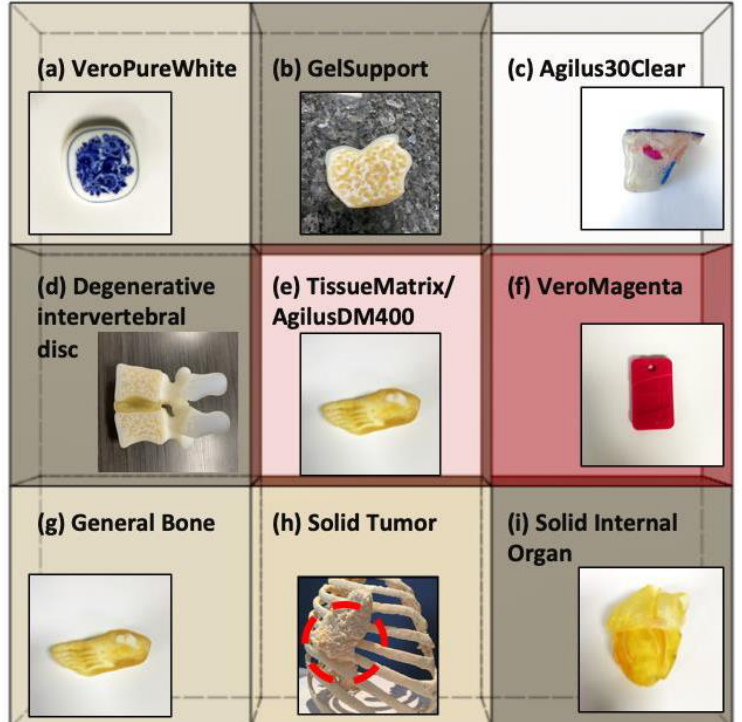
Figure 2. Nine different constitute materials of Rubik’s cube-like matrix sample printed by J750 Digital Anatomy 3D Printer (DAP) of Stratasys using voxelated digital materials (DMs) (Gel-/Tissue- /Bone-like materials) and 3D printed anatomical models printed using each material (inserts). ( a ) VeroPureWhite is a base material and has a white color. ( b ) GelSupport is utilized for printing small blood vessels or porous space in bones. ( c ) Agilus30Clear is a transparent base material. ( d ) A DM to represent a degenerative intervertebral disc that is slightly dense. ( e ) TissueMatrix/Agi- lusDM400, 400 refers to 400 μm agilus “skin,” representing soft anatomy, commonly things like muscle, fat, and skin. ( f ) VeroMagenta is a base material having magenta color. ( g ) General bone represents any bone that is non-vertebrae, skull, long bone, or ribs. ( h ) A DM to represent a tumor in the bone. ( i ) A DM to represent a solid internal organ, any solid internal organ. Tech- Labs and Stratasys took the pictures of all anatomical models.